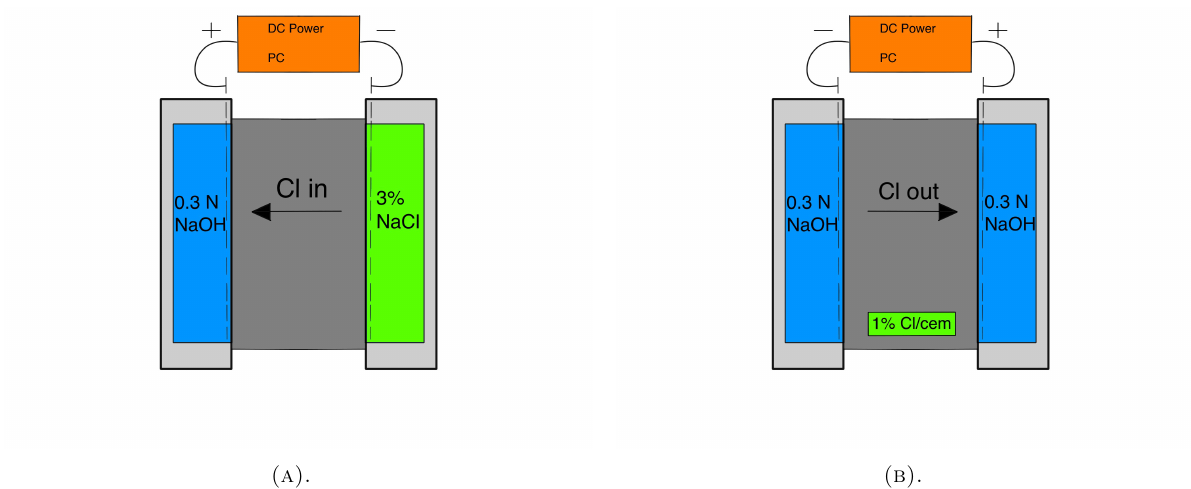
Figure 2. Scheme of accelerated chloride a) penetration test and b) extraction test.